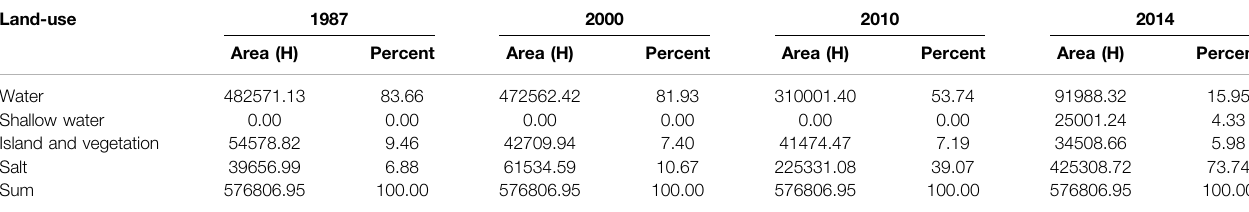
TABLE 1 | Area and percent of land-use class for LU, 1987 to 2014.